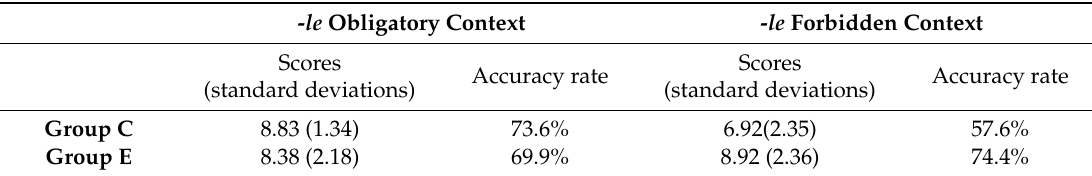
Table 4. Summary of two groups’ performance in